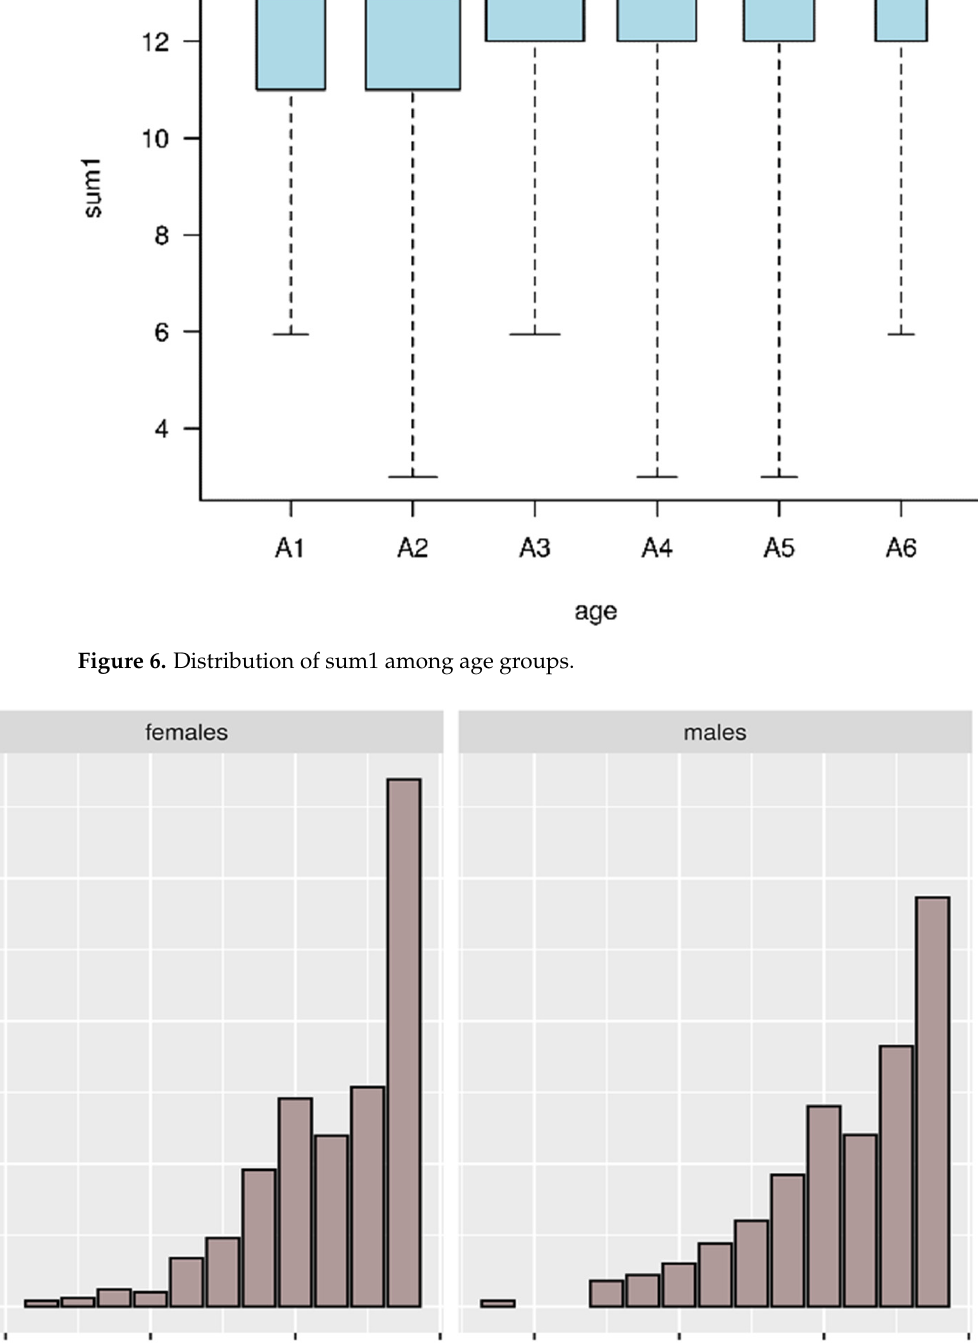
Figure 6. Distribution of sum1 among age groups.